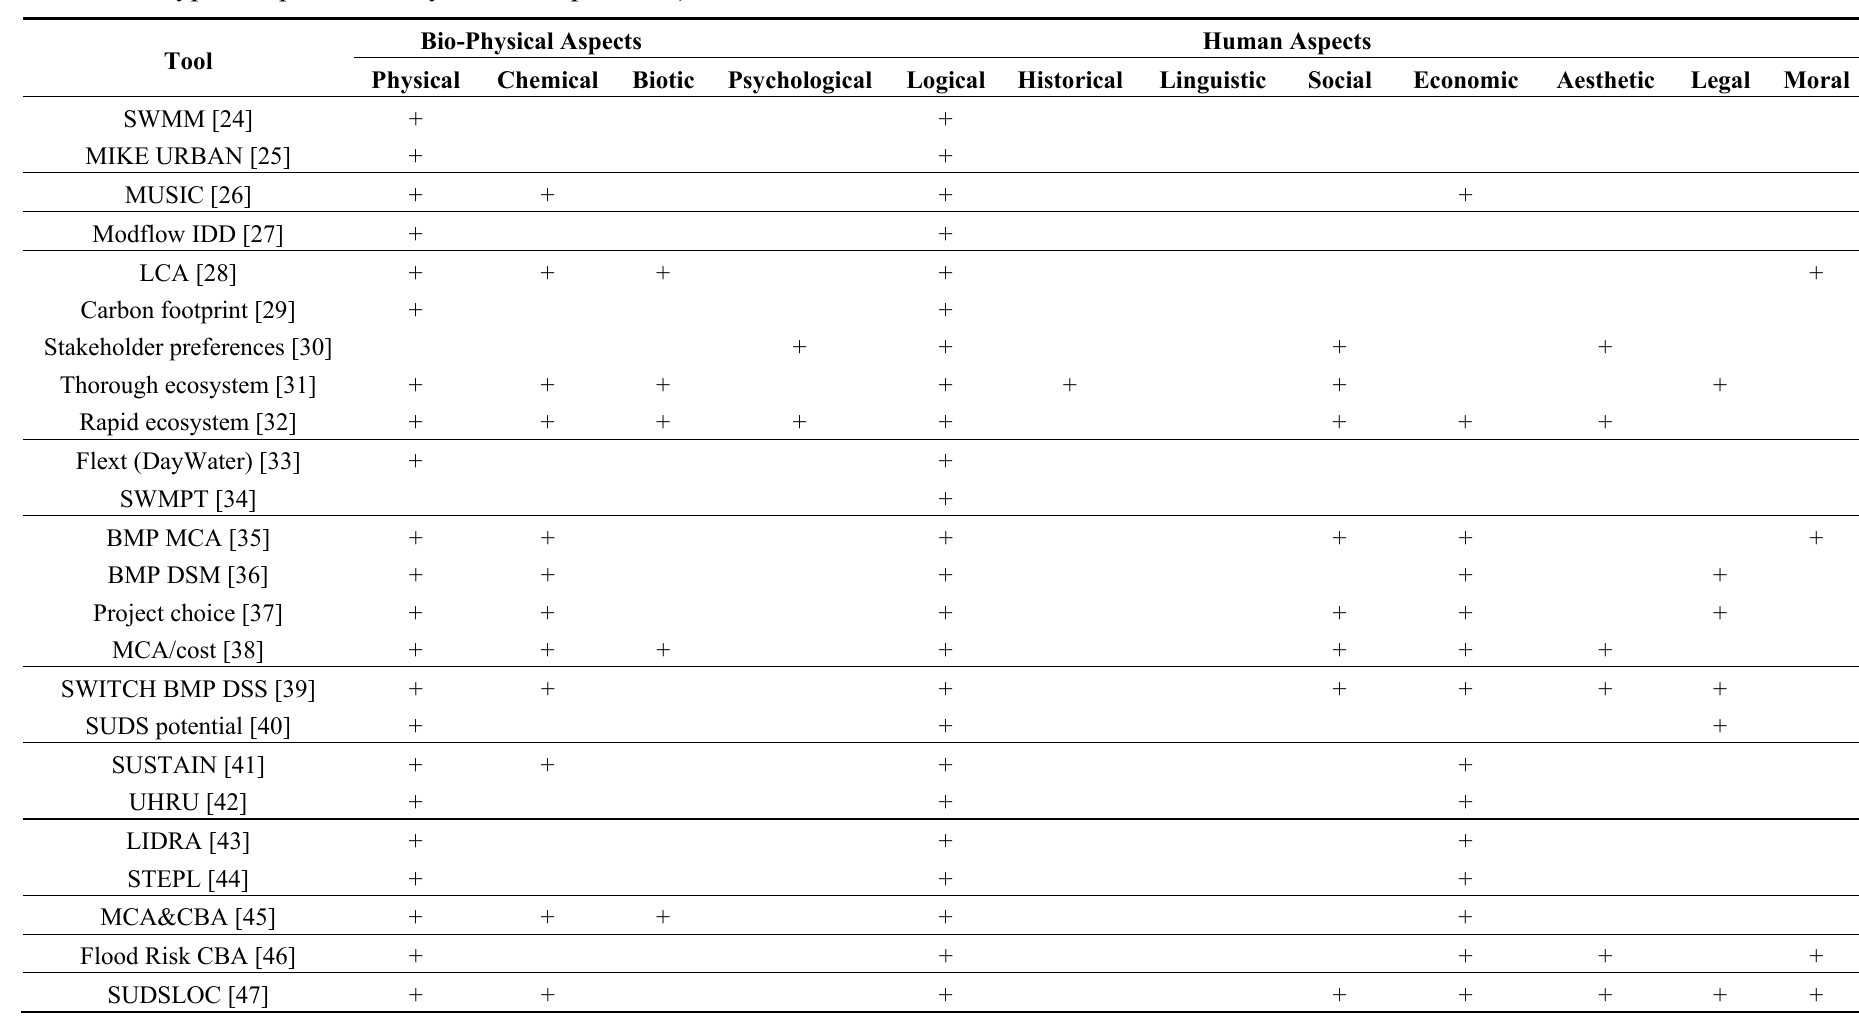
Table 3. Aspects of water addressed by the tools reviewed in this paper. The tools are kept in the same horizontal groups as in Table 2 (reflecting which types of questions they aim to help